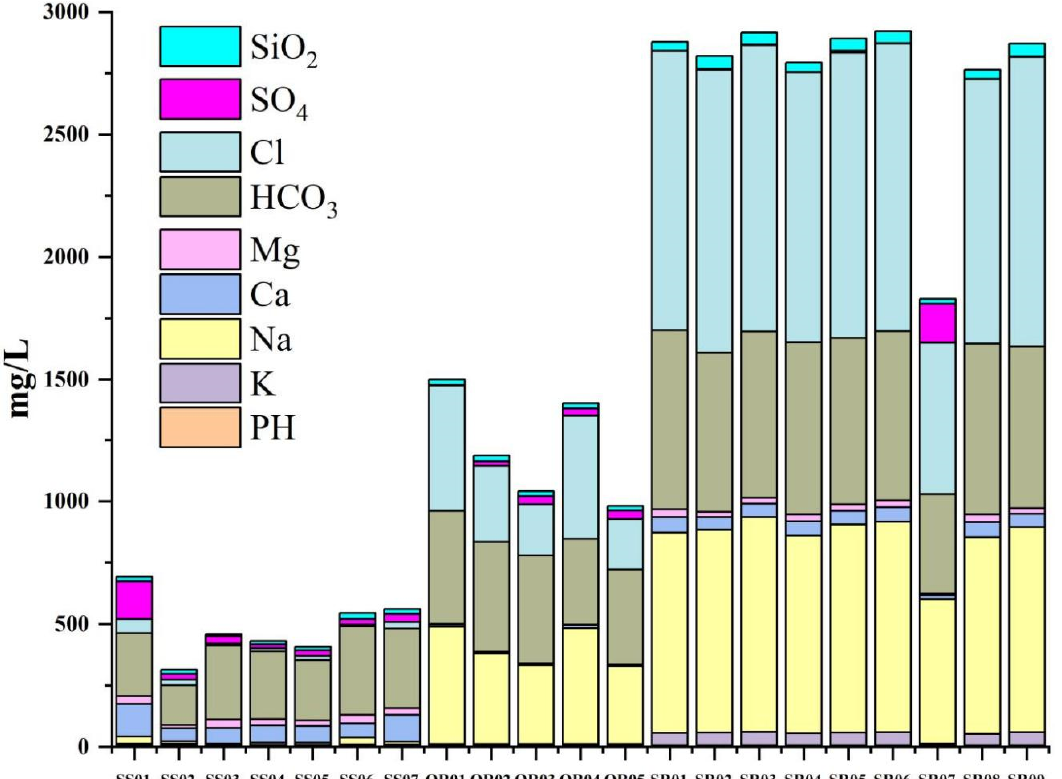
Figure 3. Major ion concentrations in water samples from the geothermal field in Rongcheng, Xiong’an New